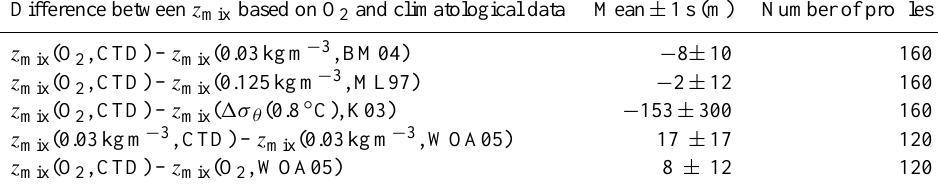
Table 2. Mean differences between z mix based on CTD data, z mix climatologies and climatological World Ocean Atlas 2005 temperature, salinity and oxygen data (WOA05).